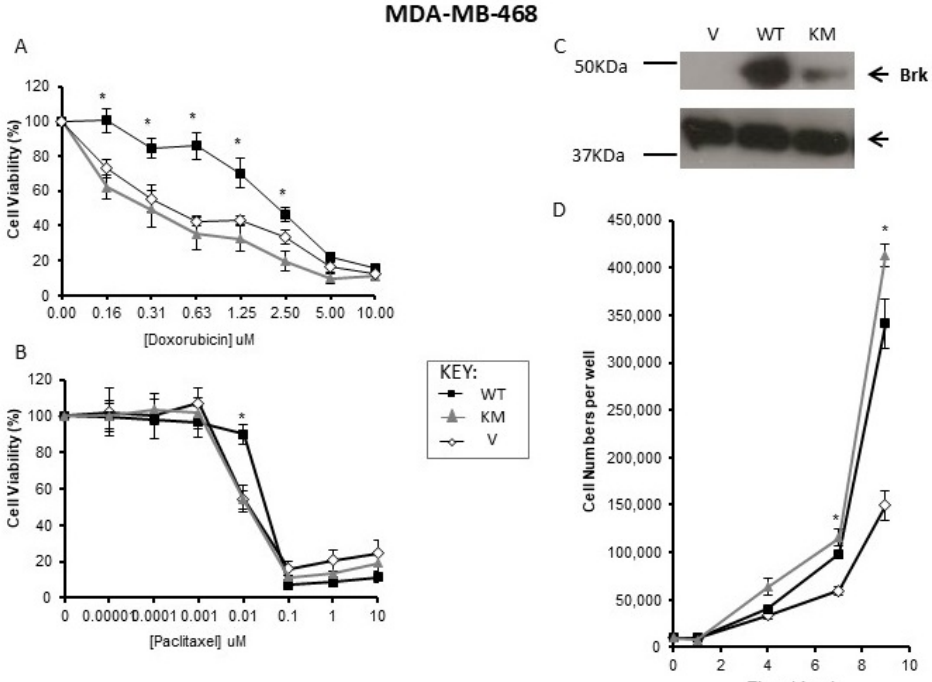
Figure 3. Brk’s effects on drug responses are dependent on kinase function and not proliferation. MDA-MB-468 cells, stably transfected with empty vector (V) or constructs expressing either wild-type (WT) or kinase-inactive Brk (KM), were seeded and allowed to adhere overnight in 96-well plates. Cells were treated with either ( A ) doxorubicin (upper panel) or ( B ) paclitaxel (lower panel) for 72 h. Cell viability was determined by MTT assay and expressed as a percentage of the control (vehicle only) wells. The mean % survival (+/ − SD) of a representative experiment is plotted; * indicates p < 0.05. ( C ) Whole cells lysates were analysed for Brk expression by Western blotting with β -Actin expression as a loading control. ( D ) Cells were seeded into 24 well plates and replicate wells counted over 10 days.